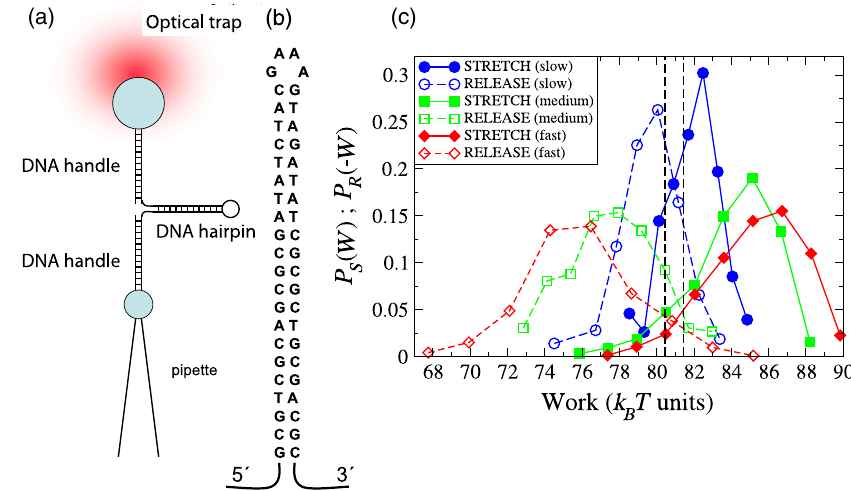
FIG. 7. (a) Experimental setup. The DNA hairpin whose sequence is shown in (b) is attached to two beads. The bottom bead is kept by a micropipette and top bead is captured by an optical trap. The drawing is not to scale; the diameter of the beads is around 3000 nm, much greater than the 20-nm length of the DNA. (b) DNA hairpin sequence. Labels 5 and 3 indicate the polarity of the phosphate chain of the hairpin. (c) Typical work distributions for three different loading rates: 1 pN = s (slow, blue), 4 . 88 pN = s (medium, green), 14 . 9 pN = s (fast, red). The vertical lines show the range of the estimated experimental errors for the value of Δ F (adapted from Ref.